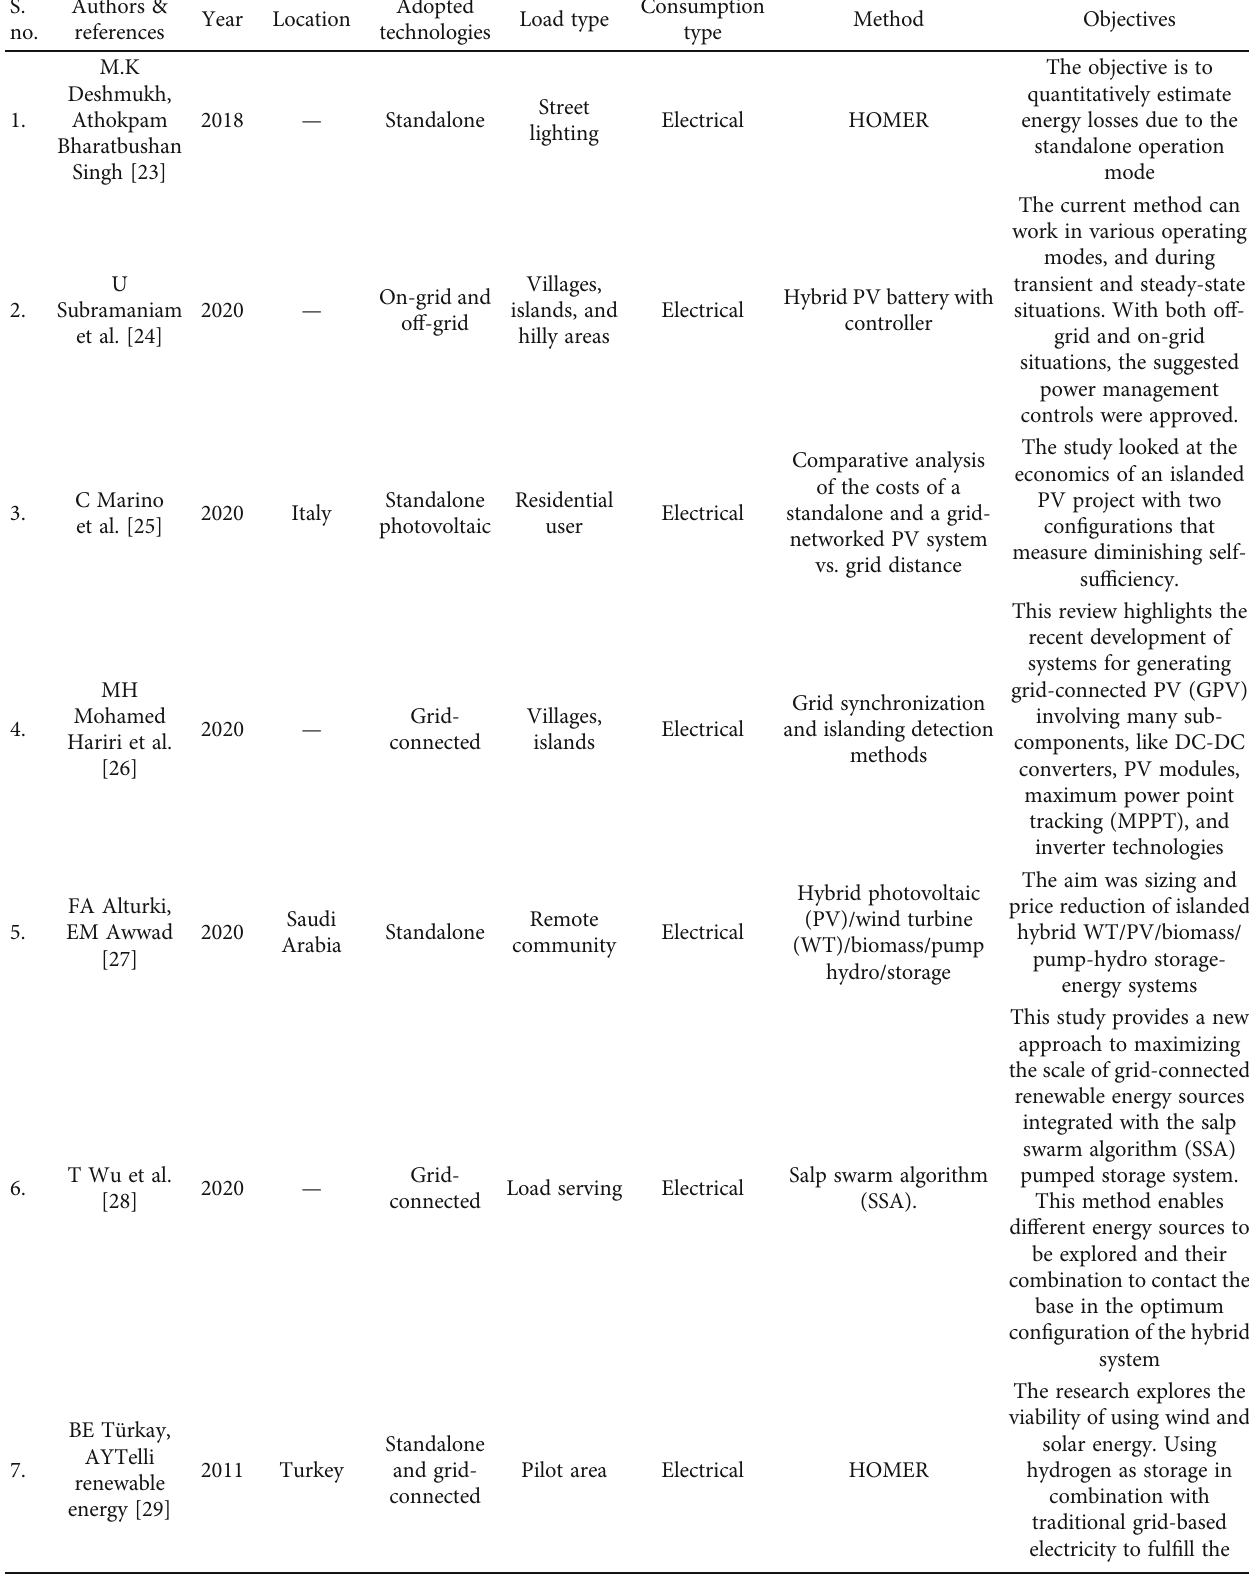
Table 1: Summary of comparative analysis based on standalone, microgrid, on-grid, and o ff -grid results.